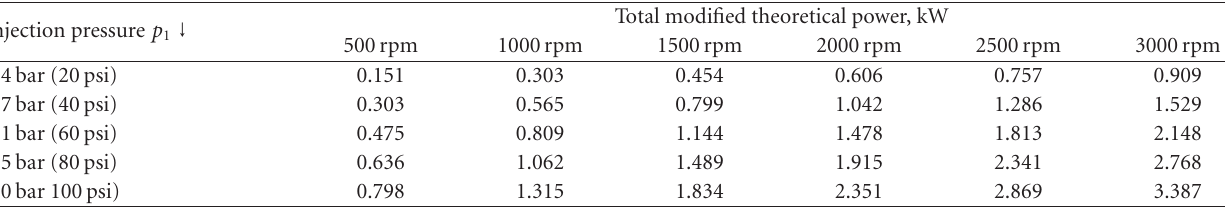
Table 2: Modified theoretical power ( W total-modified ) at D = 100 mm, d = 75 mm, vane angle ( θ ) = 45 ◦ , injection angle ( φ ) = 60 ◦ , L = 45 mm at injection pressure 20–100 psi.